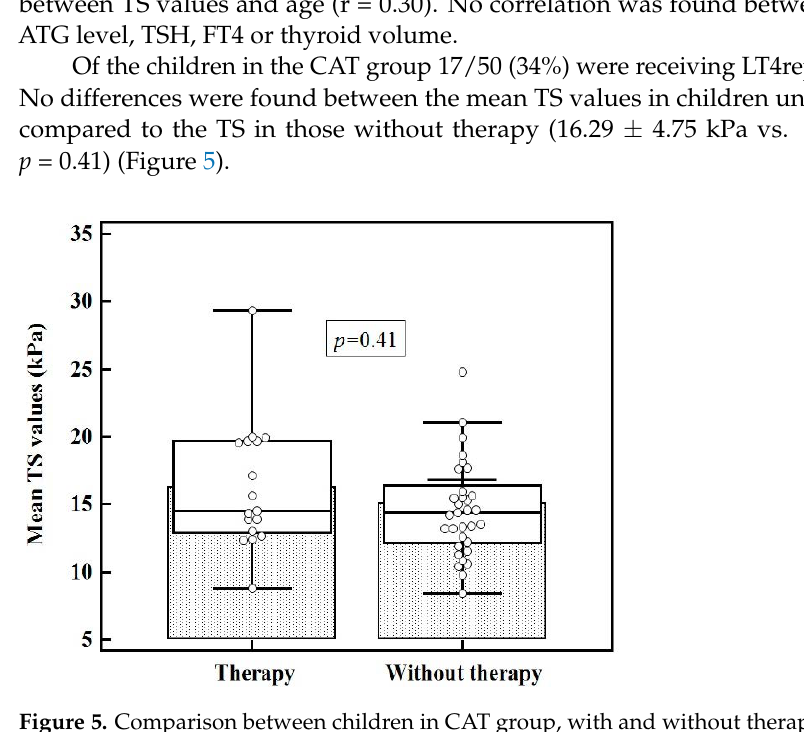
Figure 5. Comparison between children in CAT group, with and without therapy.